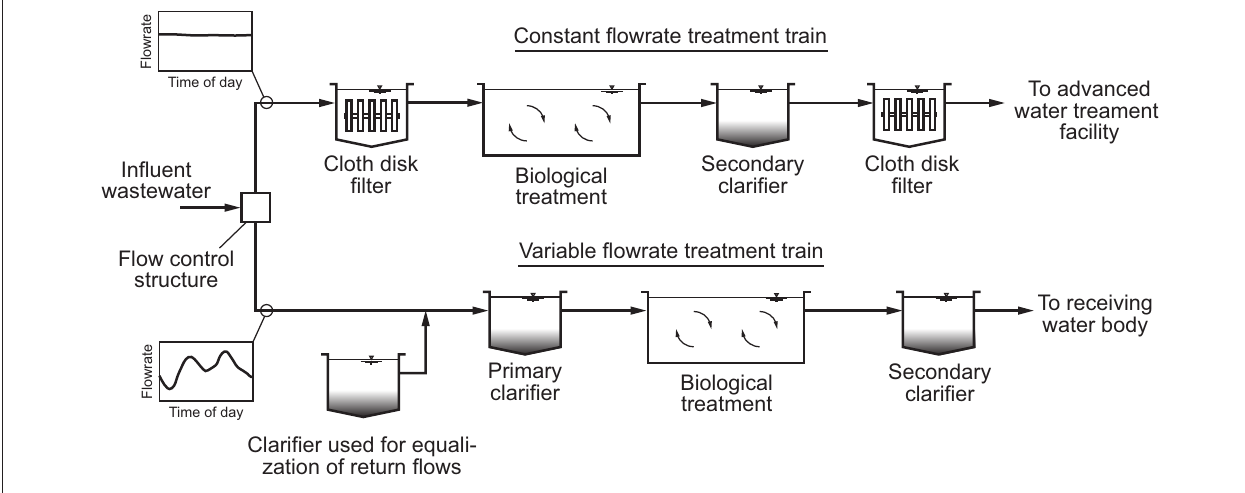
FIGURE 6 | Definition sketch for divided treatment trains in an existing or new WWTF to optimize effluent quality for advanced water treatment for potable reuse and for dispersal in the environment.